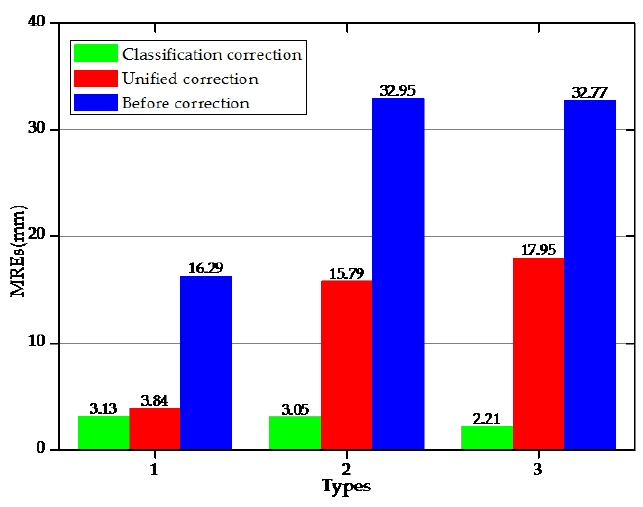
Figure 13. Comparison of mean relative errors (MREs) based on different methods under three bending shapes.